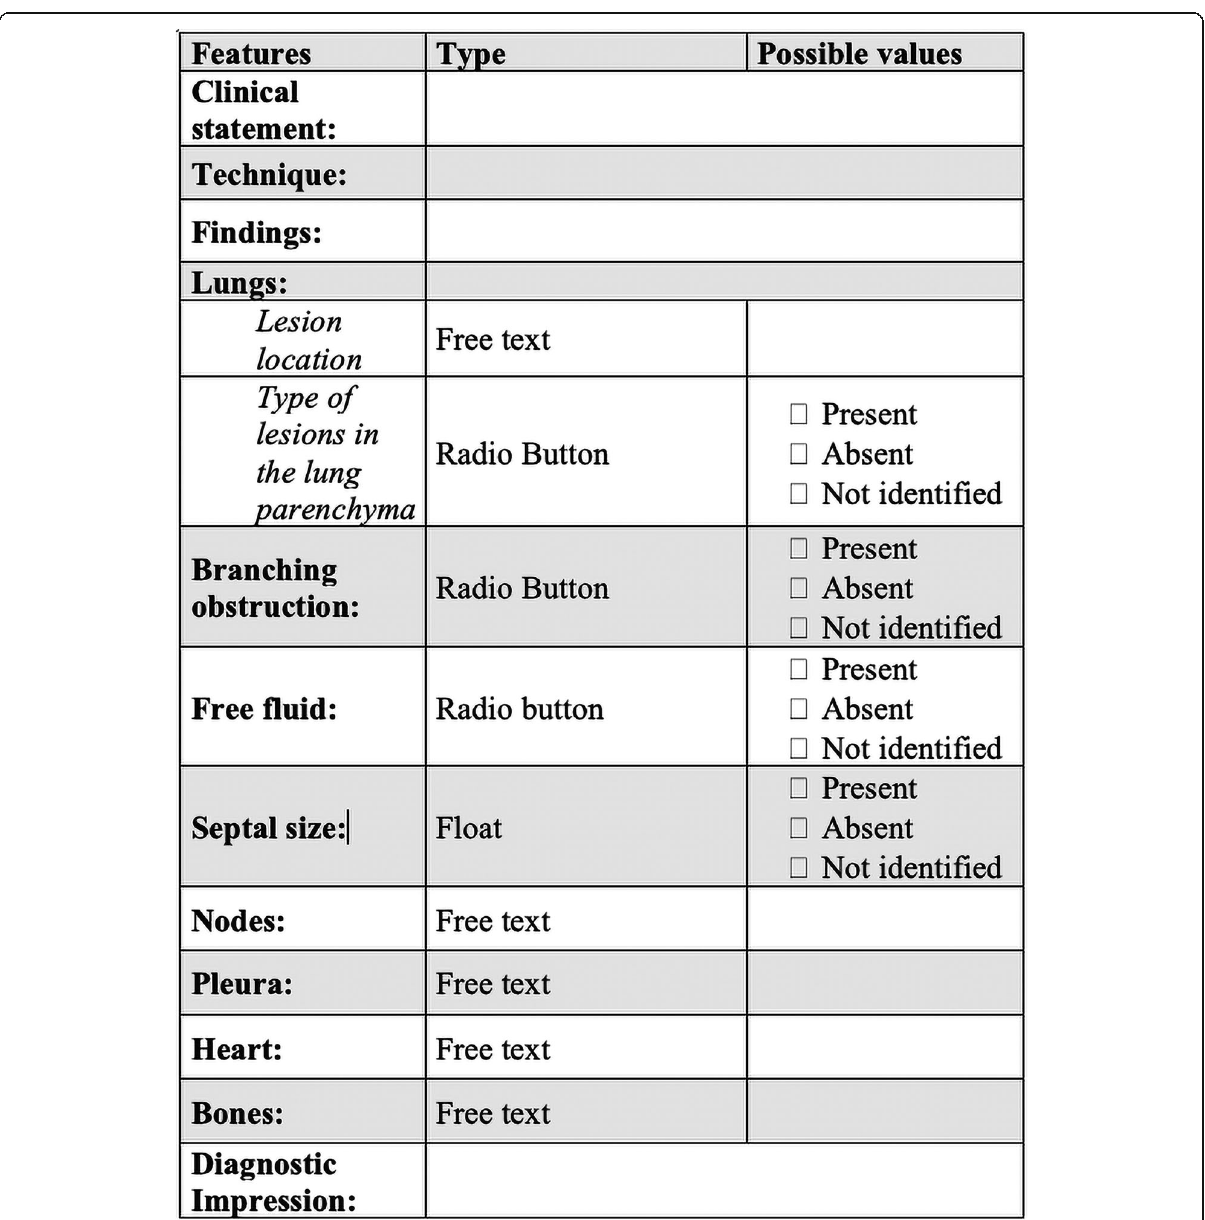
Fig. 4 Example of a reporting guideline for CT thorax examination in the assessment of environmental